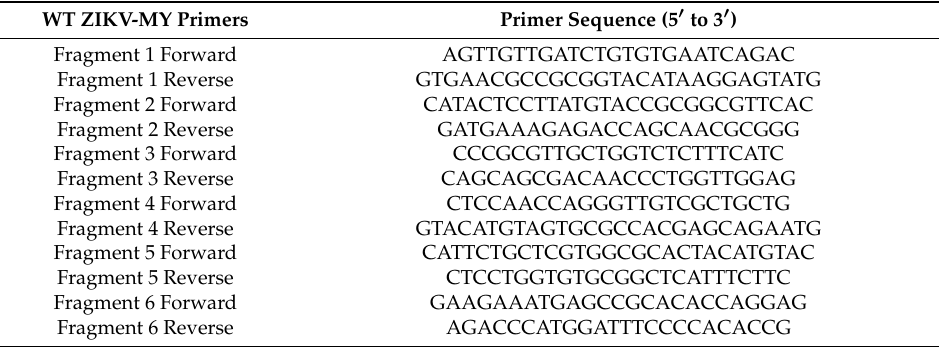
Table 1. Primers used for generation of cDNA amplicons of parental P6-740 Malaysian 1966 Zika